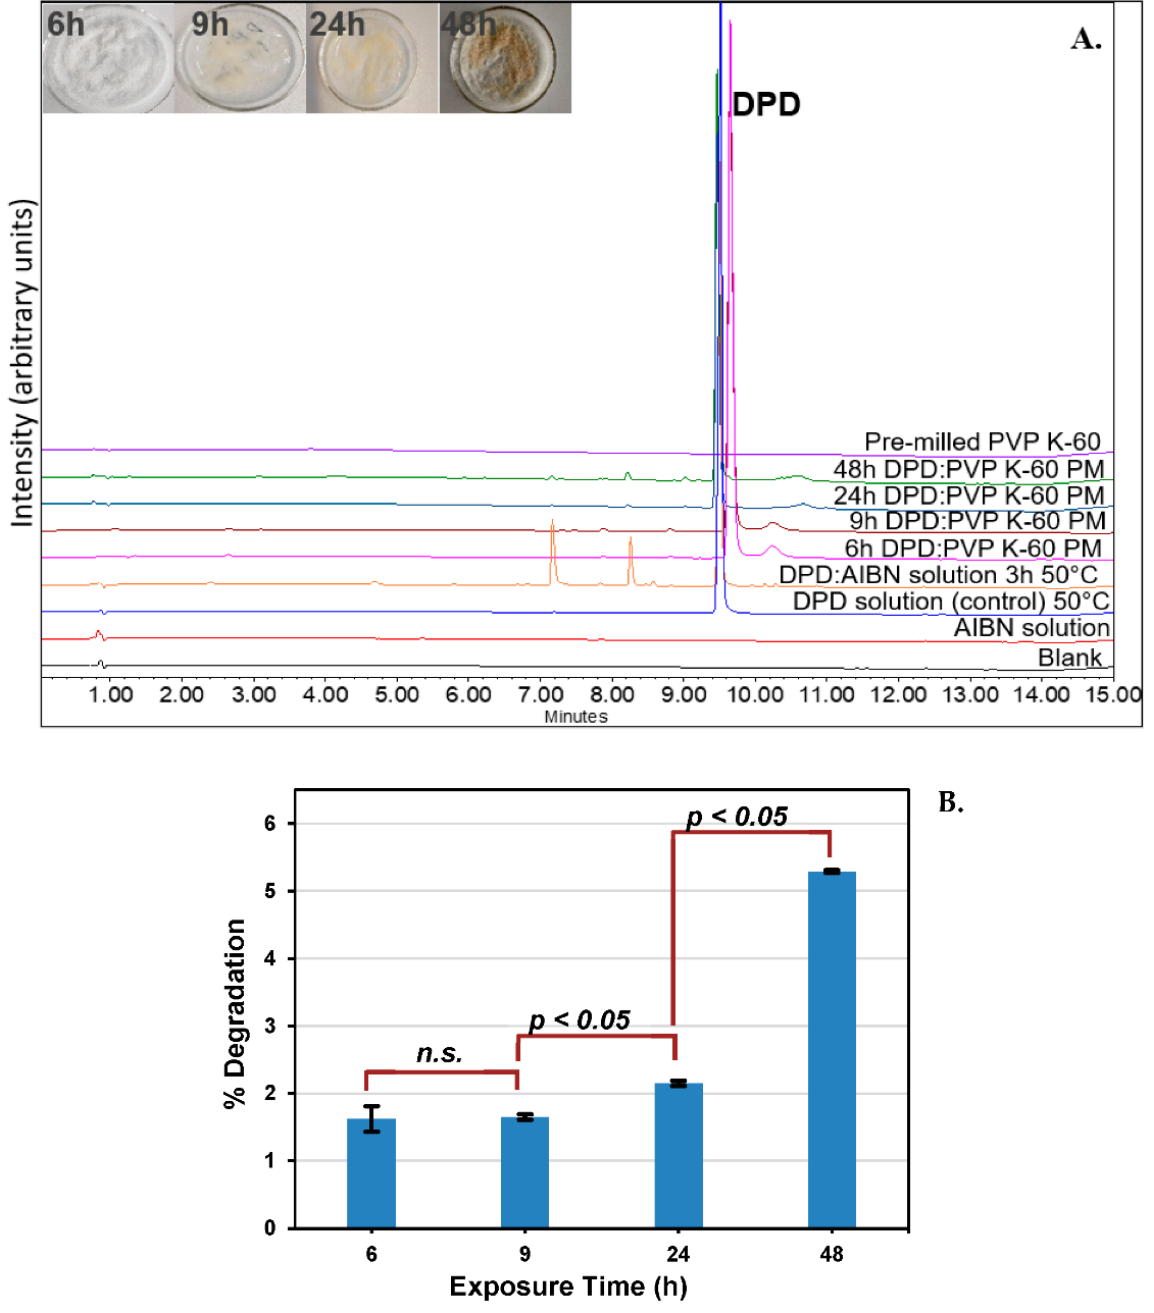
Figure 6. ( A ) Overlaid chromatogram of DPD samples after exposure in RapidOxy ® indicating enrichment of DPs. (PM denotes the physical mixture of DPD and pre − milled PVP K − 60 in a 1:10 ratio) (pictures in the inset show the sample appearance at different exposure durations); also shown in the overlay is a comparison with a solution − state stress study carried out with AIBN, indicating the formation of similar products; ( B ) Bar chart showing the test of significance in the observed degradation values of PMs as a function of exposure time in RapidOxy ® ; n.s. indicates the p − value was not significant.